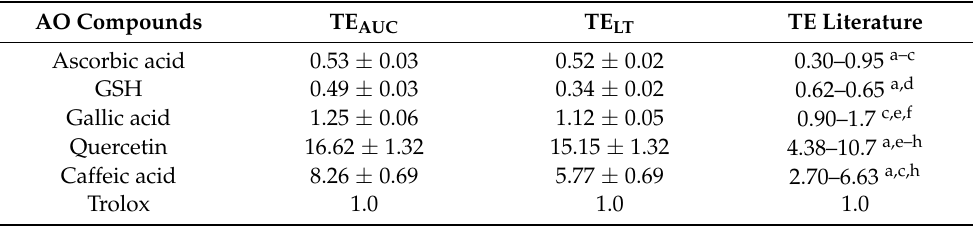
Table 3. Trolox equivalents (TE) calculated from AUC and lag time (LT) values for standard antioxi- dant